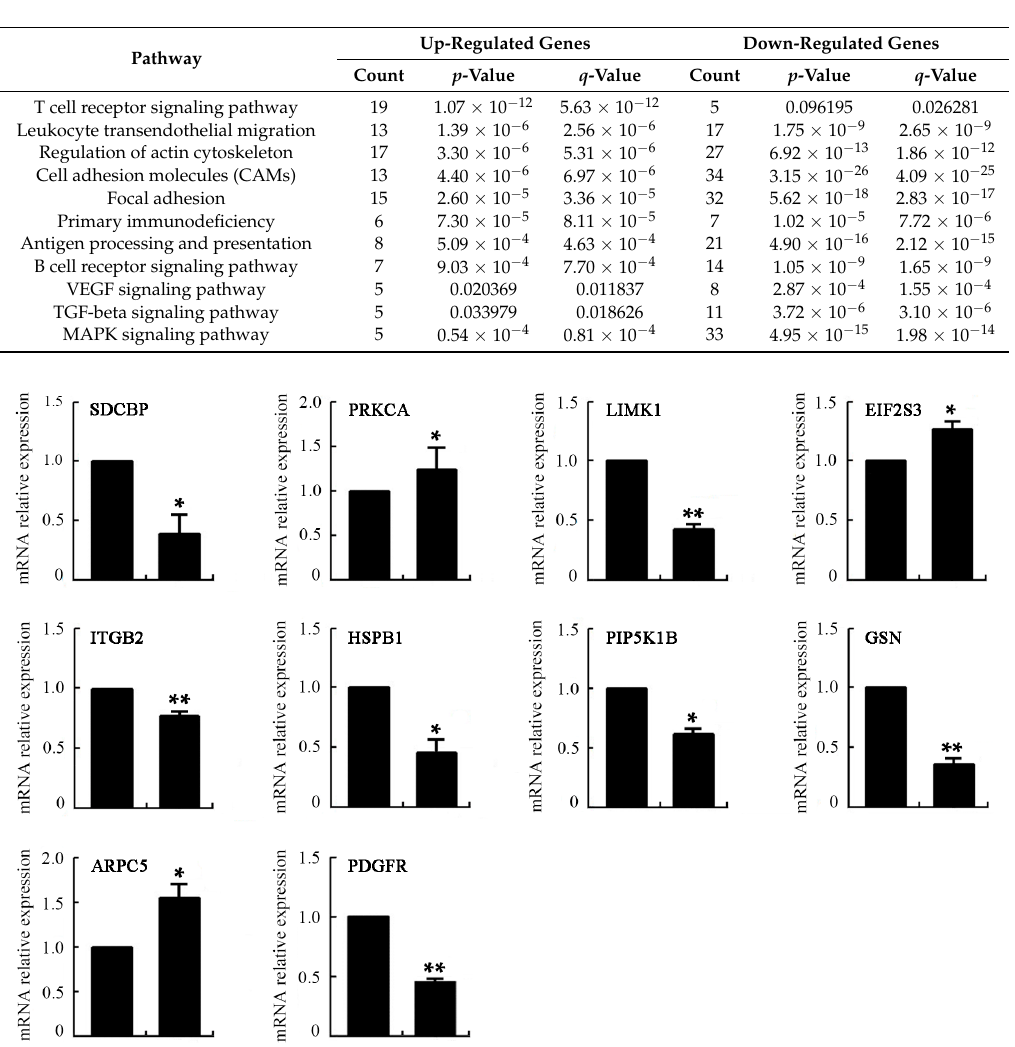
Table 4. KEGG pathway analysis of the differentially expressed genes.